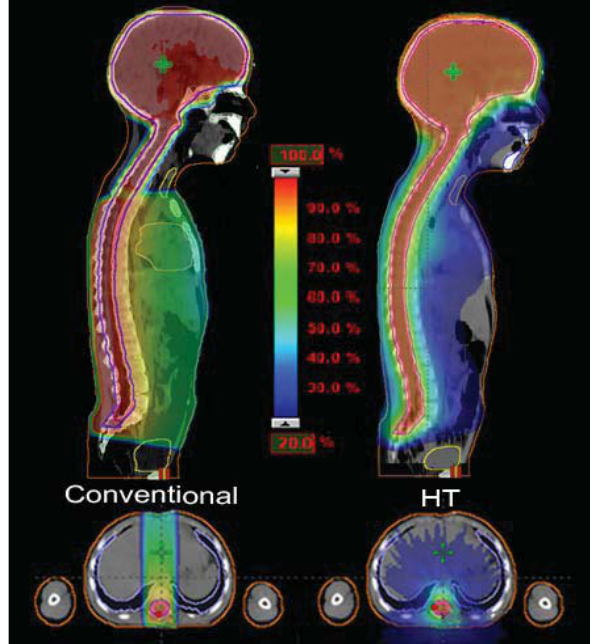
Figure 3. In a 4-year-old medulloblastoma patient, CSI delivered with HT, compared to conventional techniques, is able to give a more homogeneous dose and better conform the dose to the target, but with a larger low dose